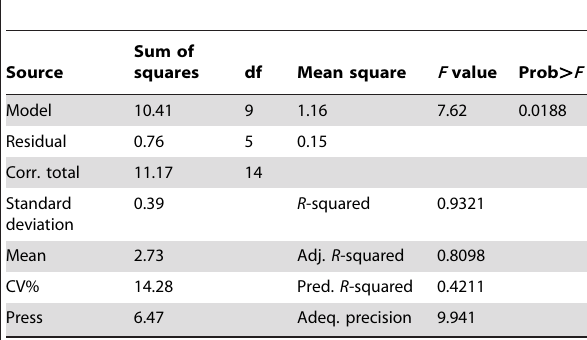
Table 3. Model summary